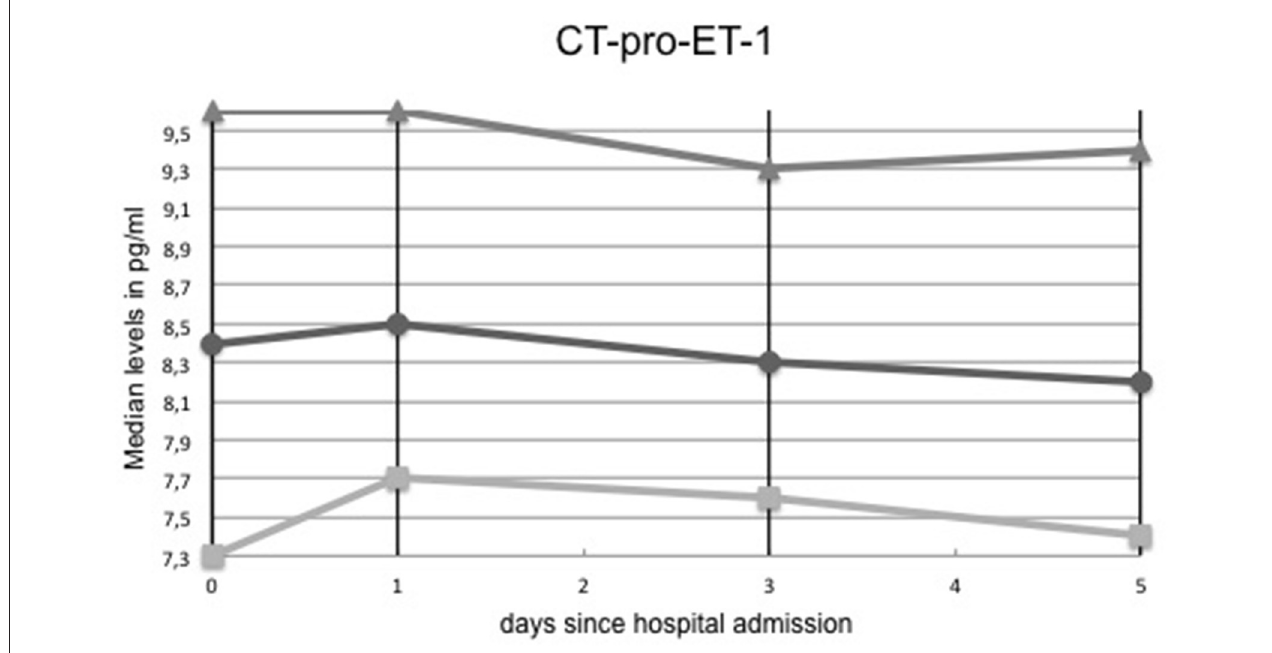
FIGURE 1 | CT-pro-ET-1 levels over time. Circles indicate median CT-pro-ET-1 levels, squares lower 95%-confidence interval limits and arrows upper confidence interval limits, respectively.